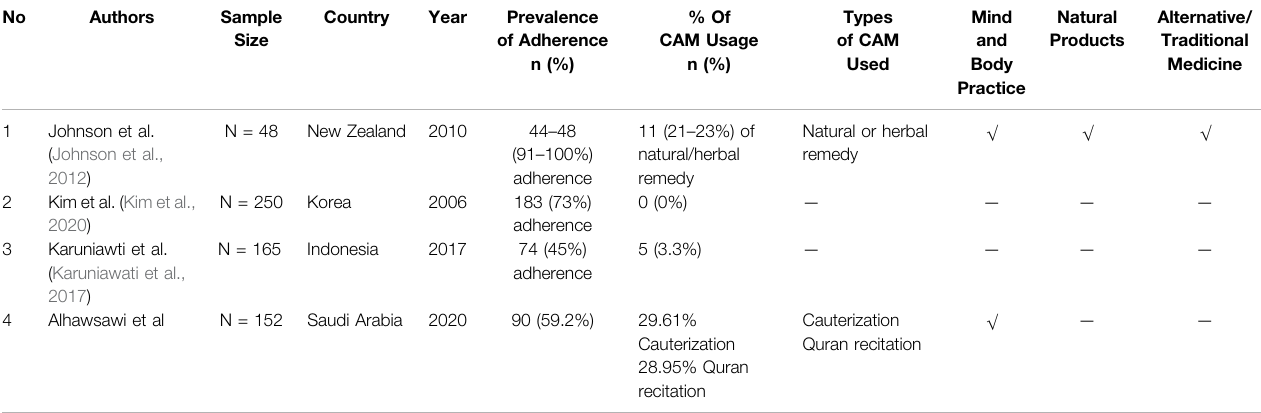
TABLE 5 | CAM usage and adherence among stroke